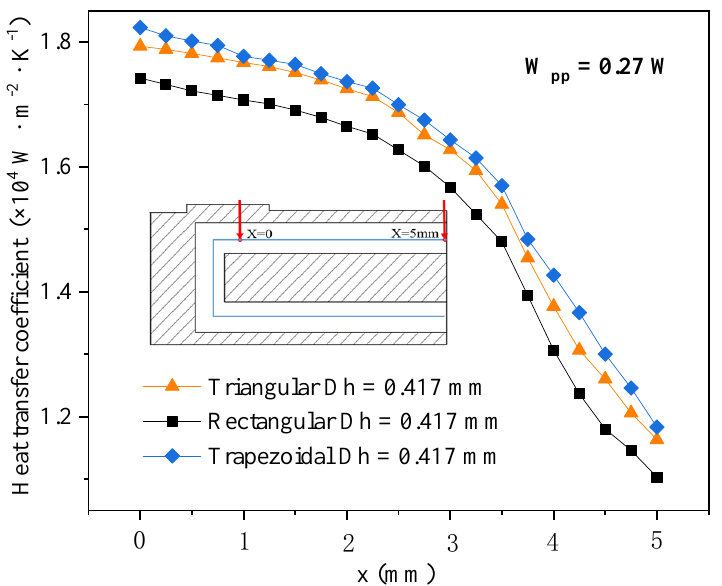
Figure 12. Comparison of local heat transfer coefficients under the same hydraulic diameter (0.417 mm. W pp = 0.27 W).